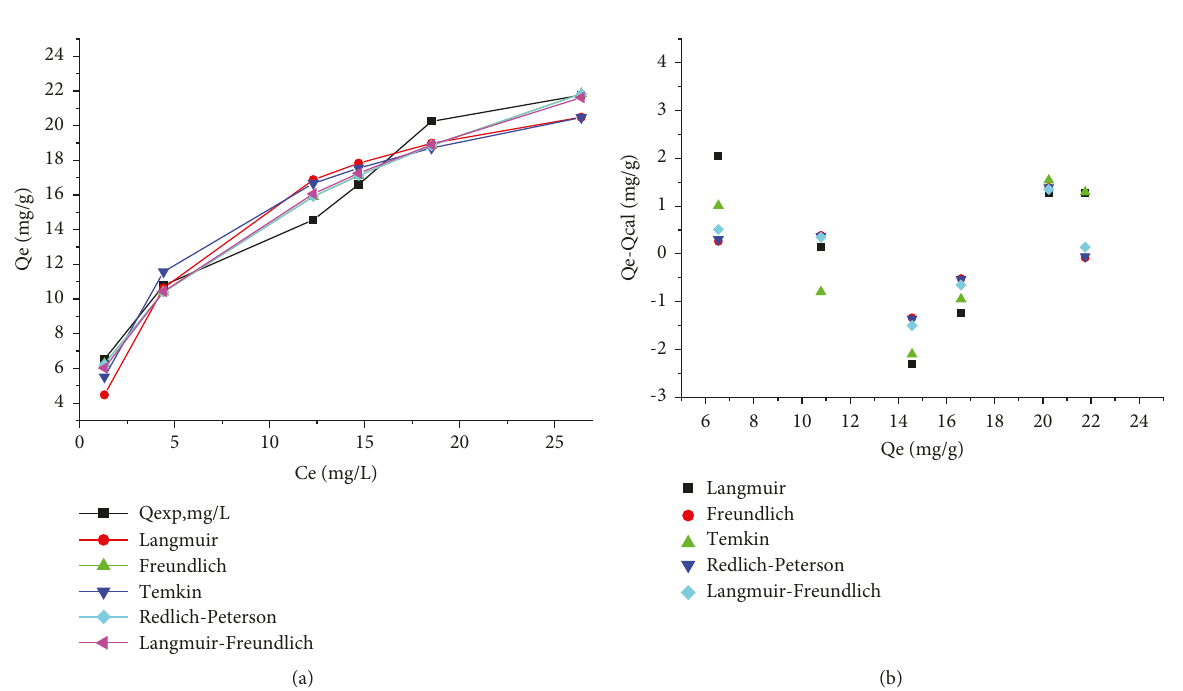
Figure 8: Non-linear isotherm (a) and residual (b) plot for copper(II) fumarate (CuFum).